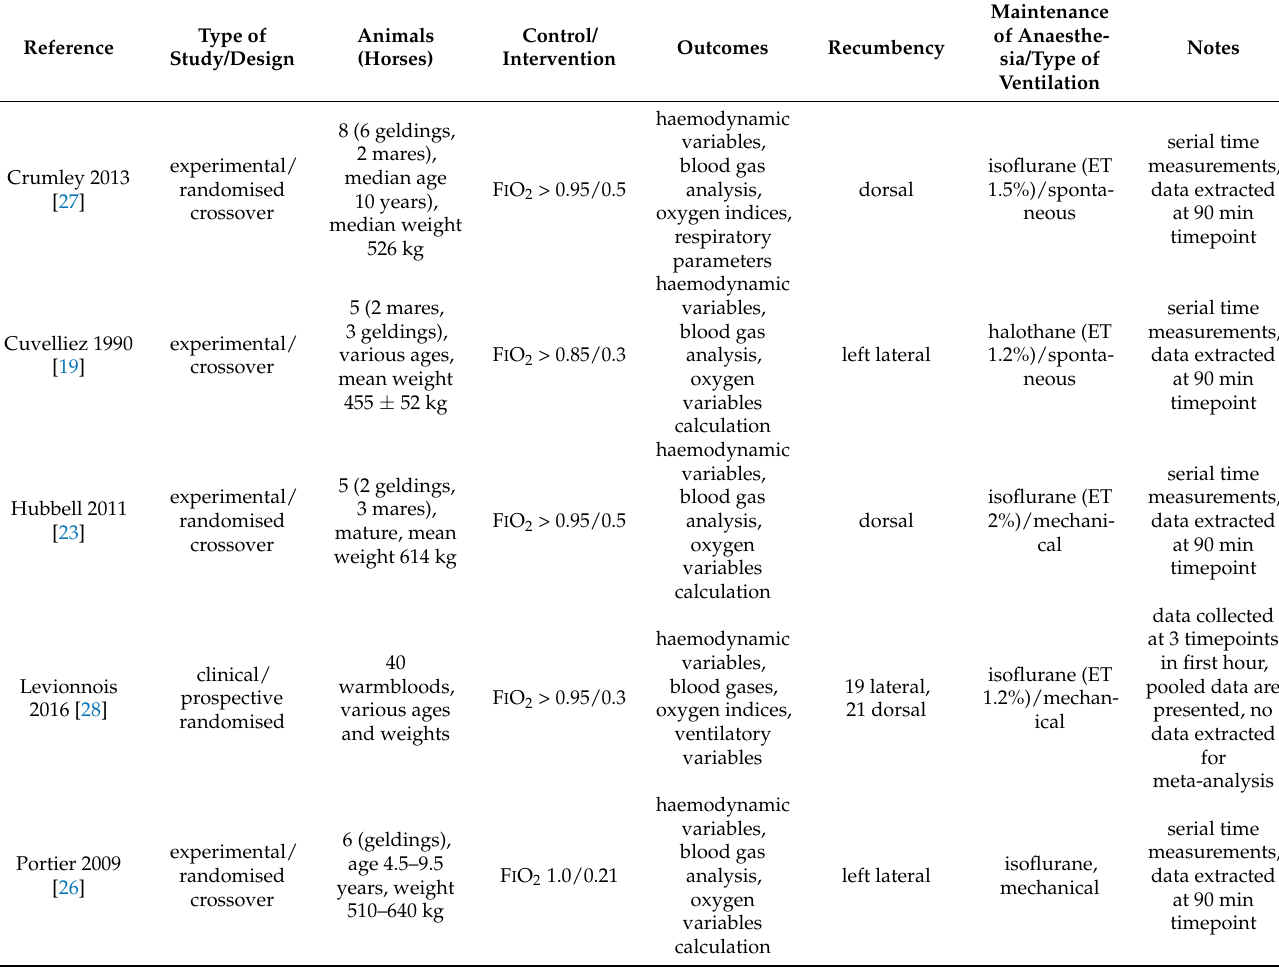
Table 1. Characteristics of the five (5) included studies, by first author alphabetical order and year of publication.